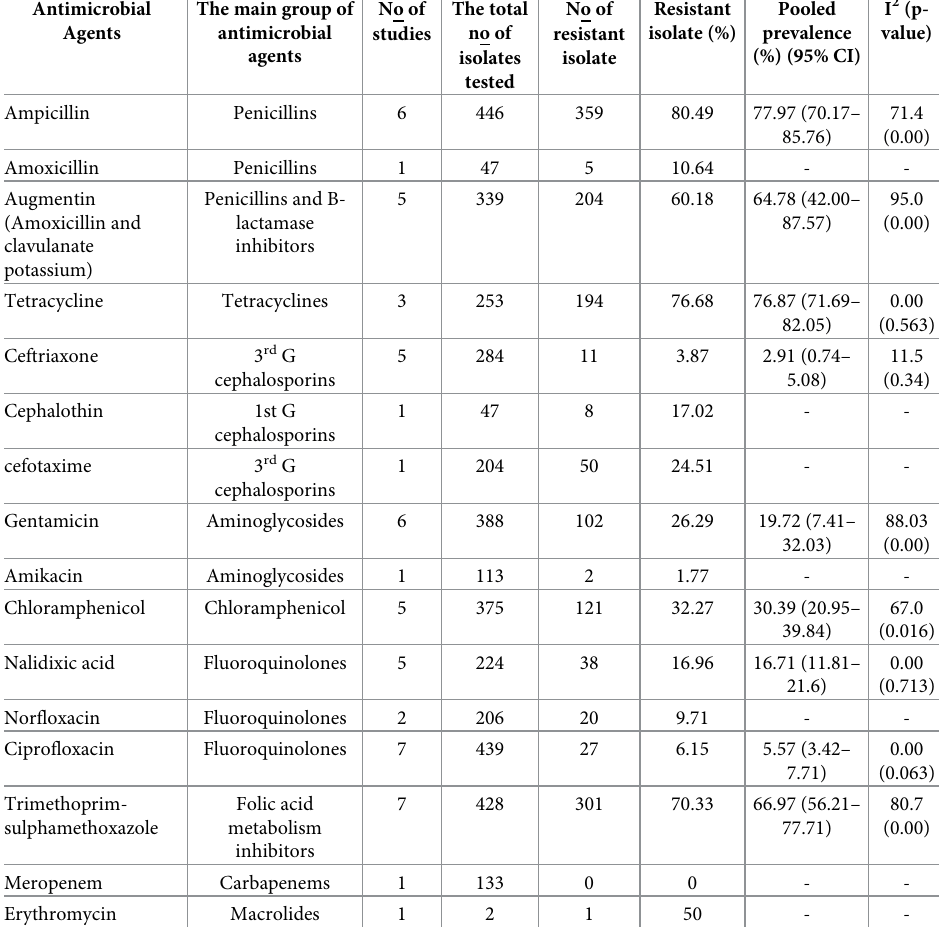
Diarrhoea is a common health problem, causing mortality and morbidity for thousands of people around the globe. Both infectious and non-infectious agents can induce the problem, among the infectious agents, enteric bacterial pathogens like diarrheagenic E . coli , S . enterica , Shigella spp., and Campylobacter spp. play important roles in the induction or severity of diar- rhoea [61]. Determining their burden in a given population is very essential to design strategies Table 7. The pooled prevalence of Escherichia coli resistance to different antimicrobial agents in Ethiopia. Antimicrobial The main group of Agents